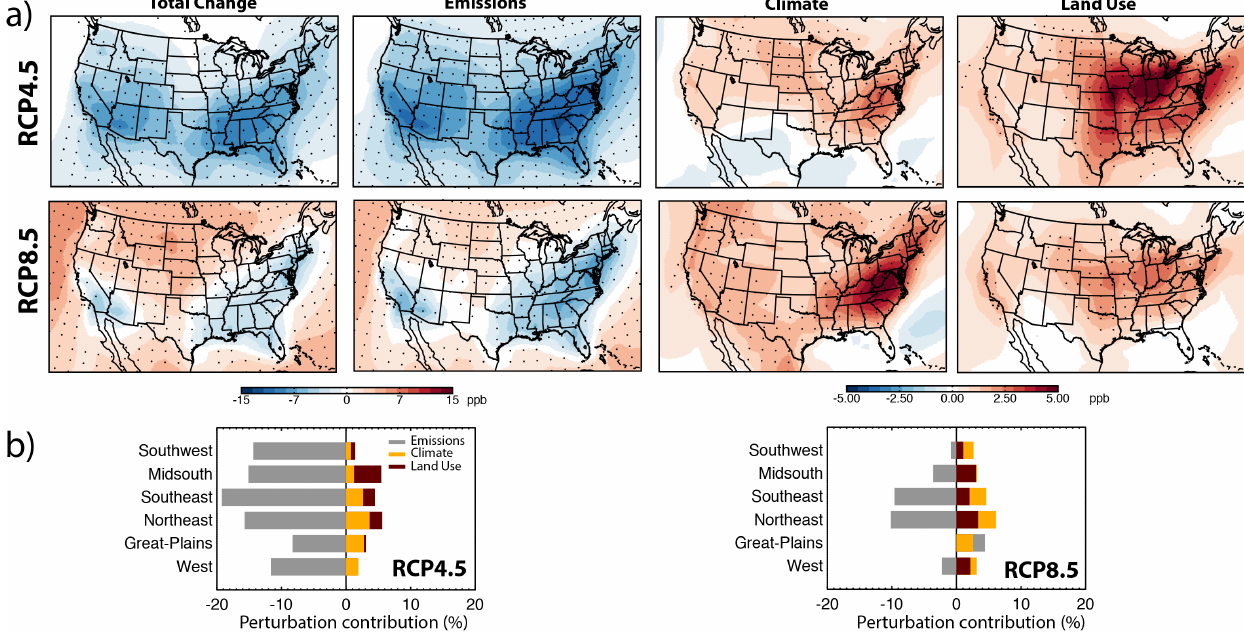
Figure 10. Projected simulated 2050–2000 changes in surface O 3 as a result of the combination of climate, land use and emission changes, and the individual changes (a) and the percentage contribution of the individual perturbations (b) for the RCP4.5 and RCP8.5 scenarios. Maps show interpolated contours from the 1.9 × 2.5 ◦ horizontal resolution output. Regions with changes that are significant at the 95% confidence level are indicated in the maps with dots, and O 3 concentrations are annual maximum daily 8h (MDA-8) averages. Bars represent the changes (%) for each individual forcing, i.e., emissions and methane levels (gray), climate (yellow) and land use (dark